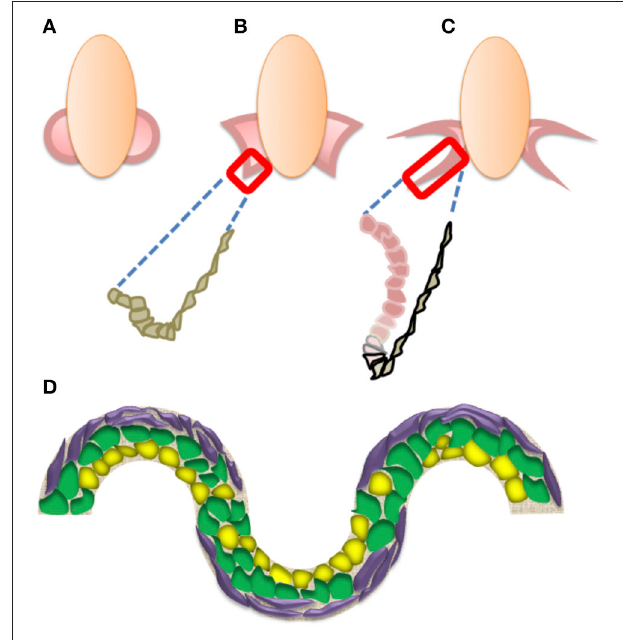
FIGURE 2 | (A–C) Schematic representation of the main steps in retinal formation. Optic vesicles form by evagination (A) , and then flatten upon the formation of hinges, where cells undergo apical constriction (B) . The next step (C) is the invagination starting at the hinge region (gray), driven by the proliferation of neural retina pre-cursors (pink) illustrated in the box in (B,C) . Pigment epithelium-fated cells are black-lined. (D) Schematic drawing of the effects of substrate shapes on stem cell differentiation. Multilineage cells (green) may take either an adipogenic (yellow) or osteogenic (purple) fate at concave or convex shapes,